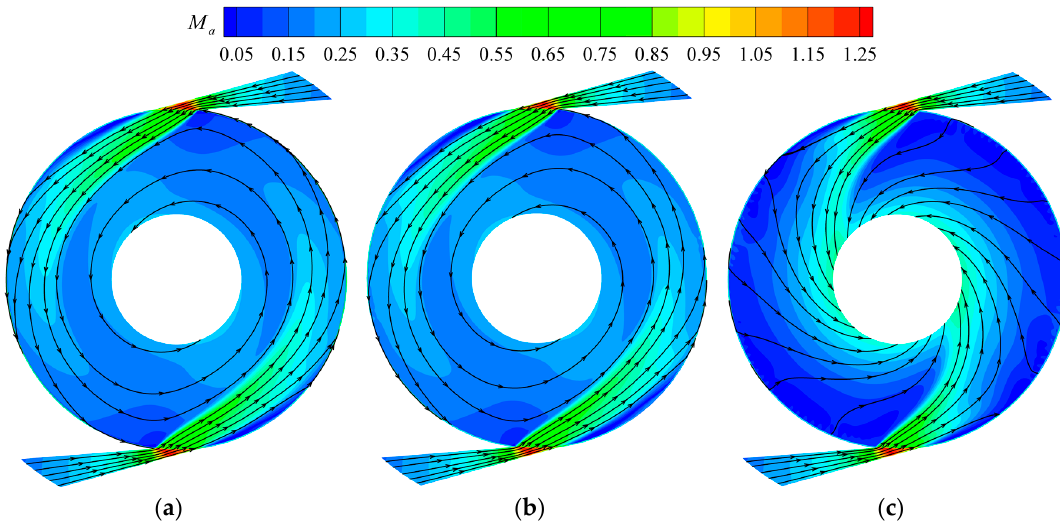
Figure 8. Mach number contours and streamlines on the mid-sections of three DCs for the one-to-one turbine Case 2-0.5 at 30,000 r/min: ( a ) DC1; ( b ) DC2; and ( c ) DC3.